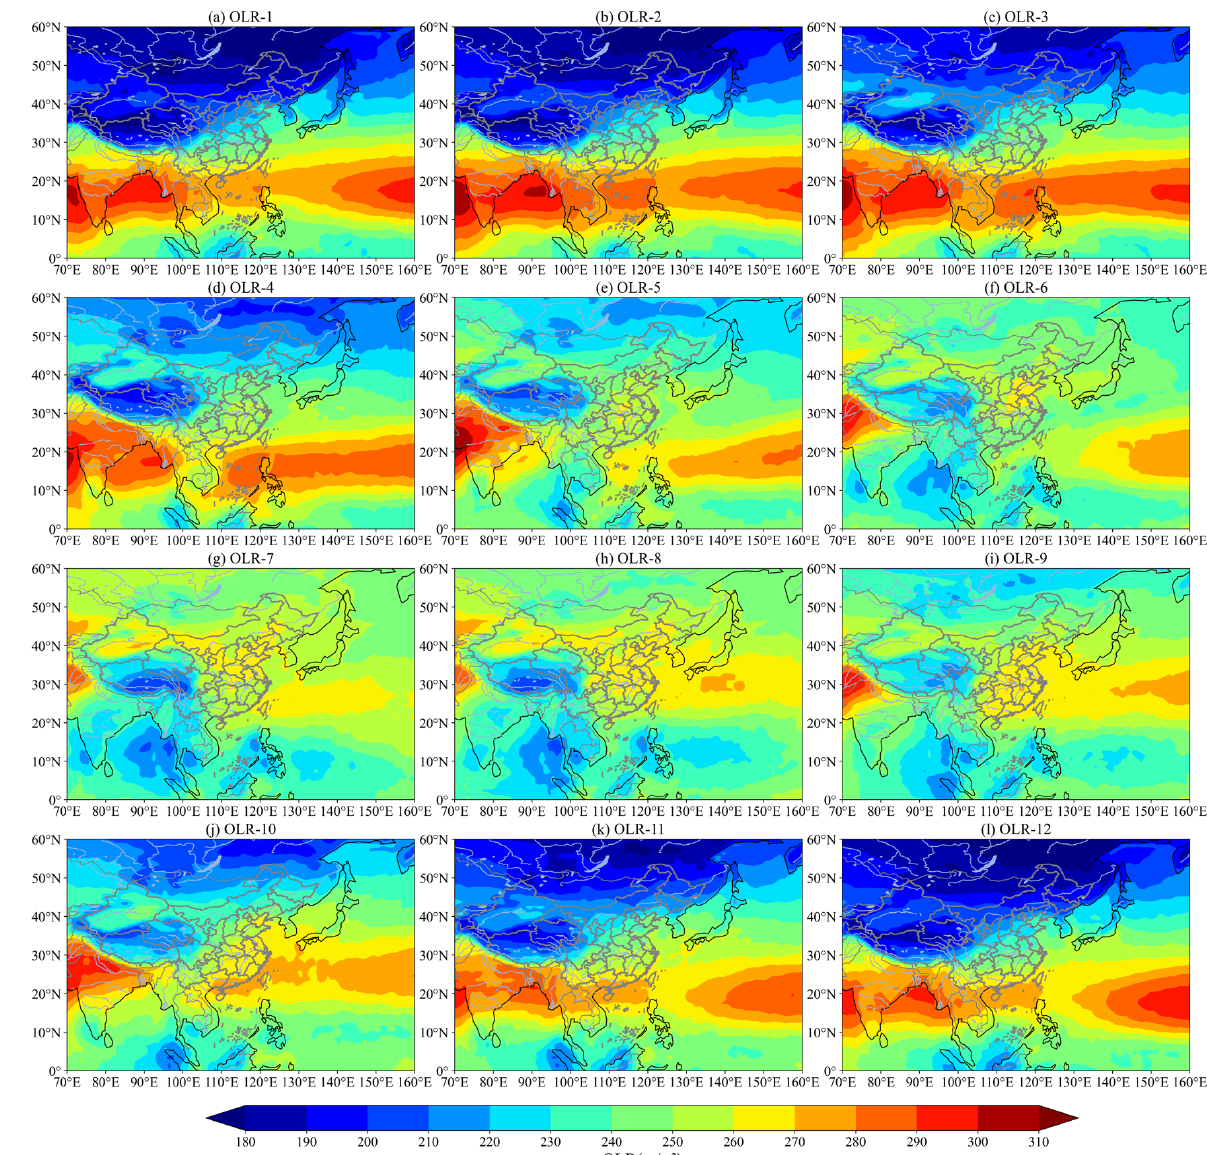
Figure 3. Average monthly spatial distribution of OLR in East Asia in the past 19 years.